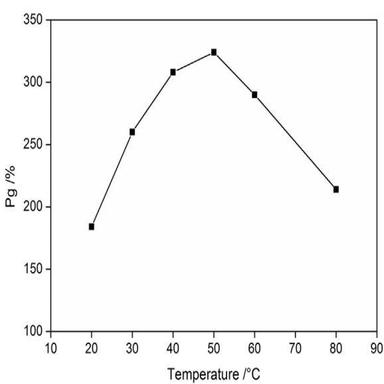
Effect of temperature on the Pg of grafted copolymer: Weight of PG = 0.5 g, weight of AM = 1.5 g, concentration of initiator (PPS) = 3 mmol/L, t = 180 min.